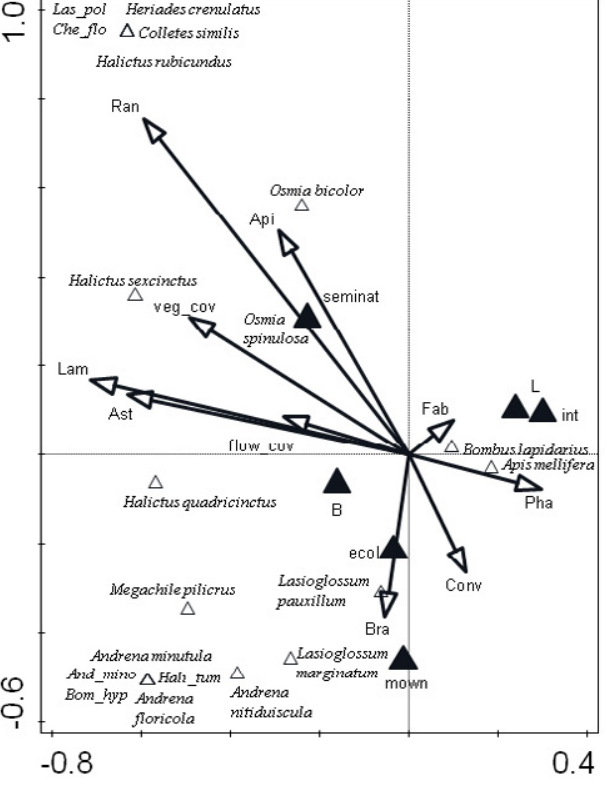
Fig 2 . Constrained ordination (CCA) of studied plots (without consideration of time dynamics). Vegetation cover (veg_cov), total flower cover (flo_cov) as well as flower cover of single plant groups: Ranunculaceae (Ran), Lamiaceae (Lam), Asteraceae (Ast), Apiaceae (Api), Fabaceae (Fab), Convolvulus (Conv) & Phacelia (Pha) were plotted as passive variables. B - location Bisamberg, L – location Leopoldsberg/Nussberg, seminat – semi-natural grassland, mown – intensively used grassland, ecol – flower strips in organic vineyards, int - flower strips in traditional vineyards. Bee species with the highest explanatory values are shown (see Table 3). Following species names are shortened: And_mino - Andrena minutuloides, Bom_hyp - Bombus hypnonum, Che_flo - Chelostoma florisomne, Hali_tum - Halictus tumulorum, Las_pol - Lasioglossum